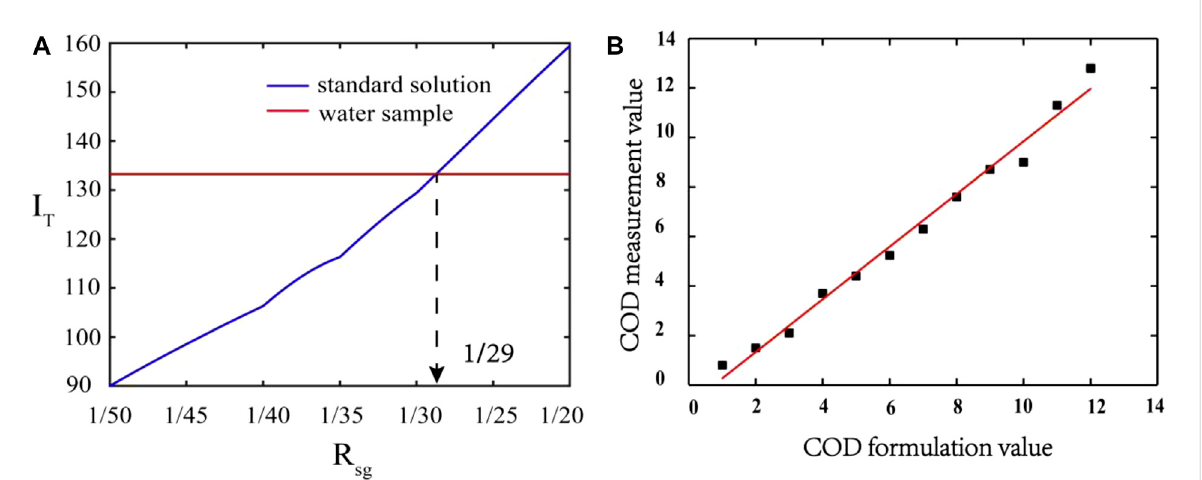
FIGURE 4 (A) Theintegrated- fl uorescence-intensityofstandardsolutionandnaturalwater(redlineistheresultofnaturalwatersamplecollectedinRiyue lake, purple line is the result of standard solution) (B) The correlation between COD value of formulation and measurement (vertical direction presents COD formulation value, horizontal direction presents COD measurement value).